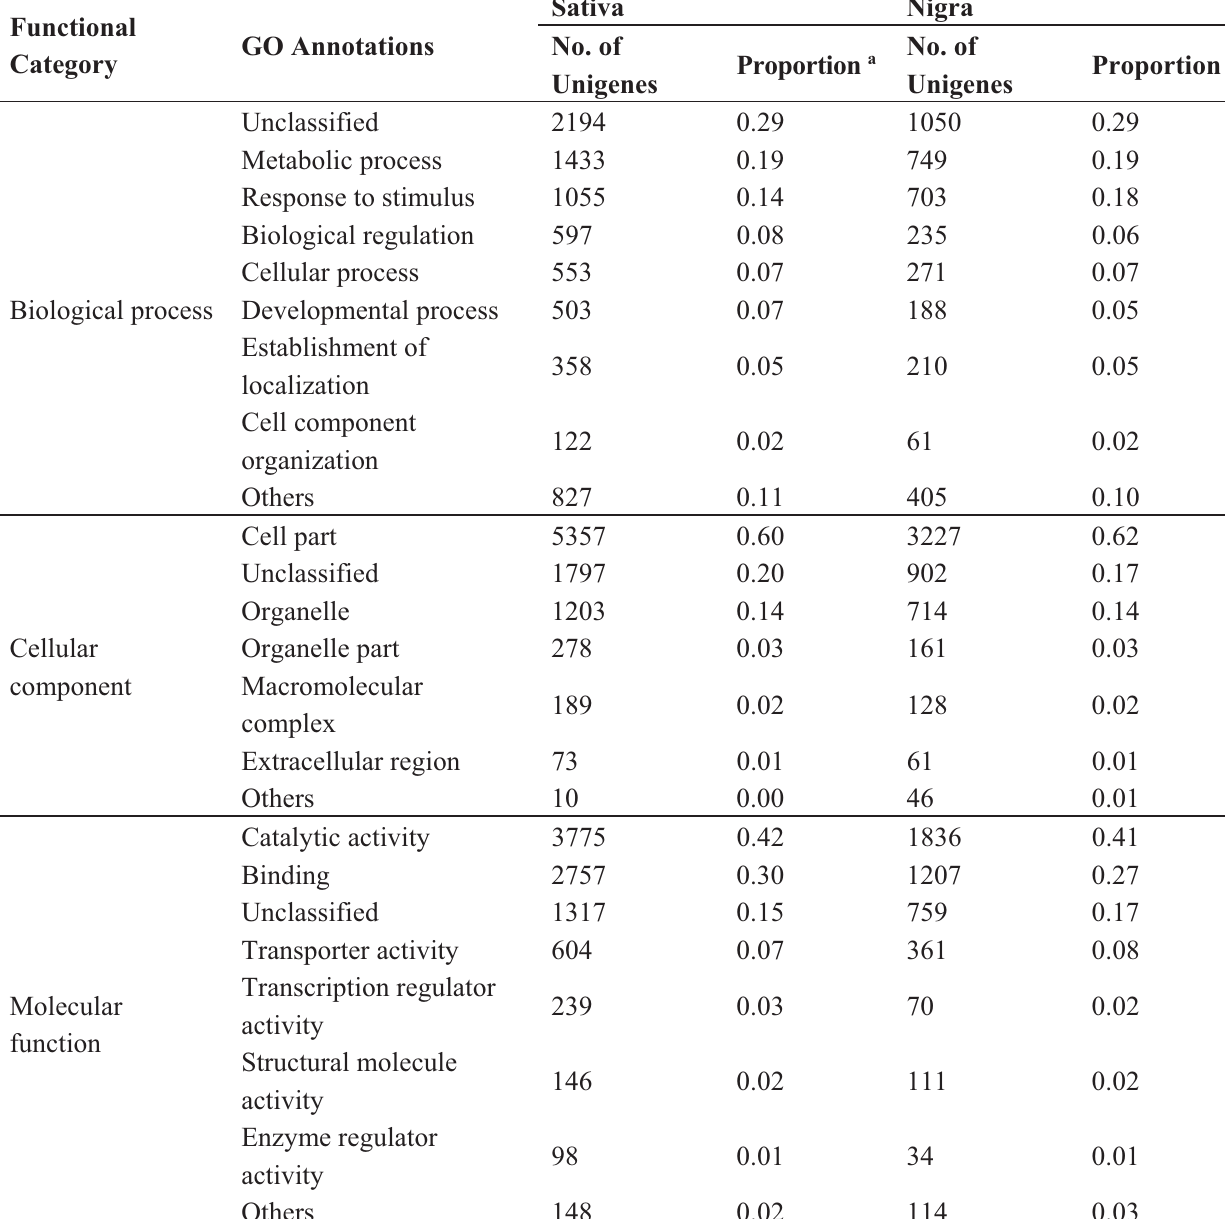
Table 2. Gene Ontology (GO) annotation results assigned to functional categories in the Vicia sativa nigra and sativa